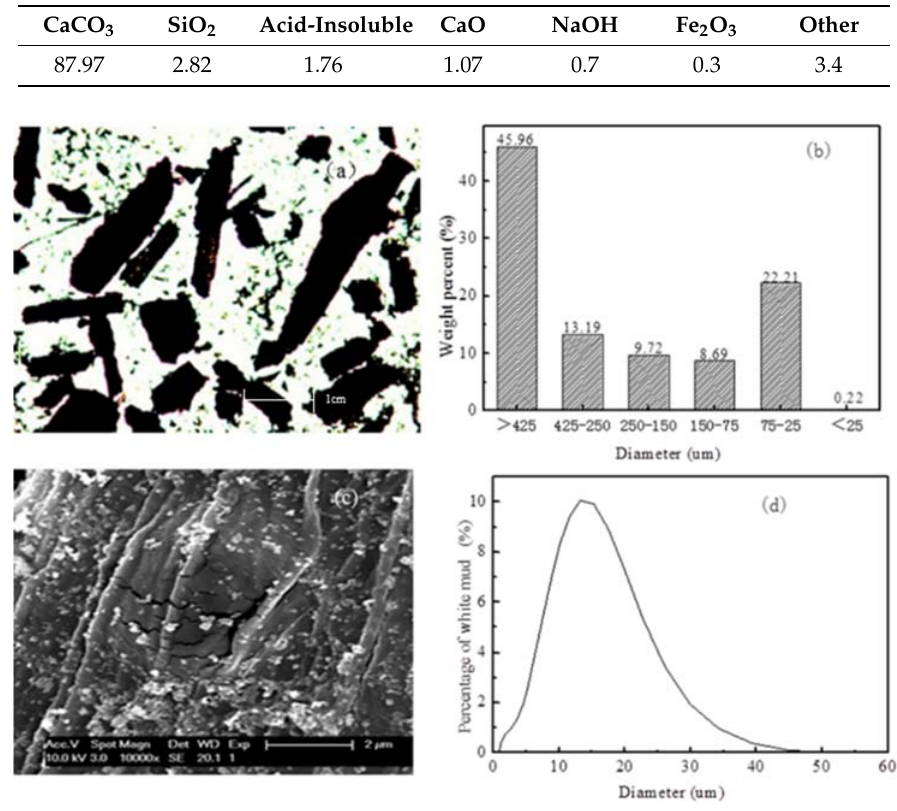
Figure 2. Analysis of bamboo residue: ( a ) optical micrograph of BRF at 50× magnification; ( b ) size of BRF; ( c ) SEM of WM at 10000 x magnification; ( d ) size of WM.